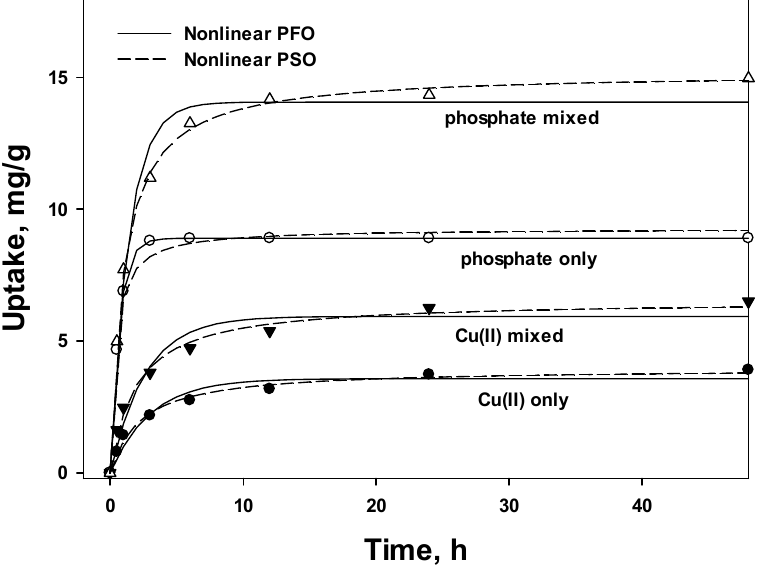
Figure 5. Nonlinear pseudo-first-order (PFO) and pseudo-second-order (PSO) kinetics of Cu(II) and phosphate under single and mixed conditions.